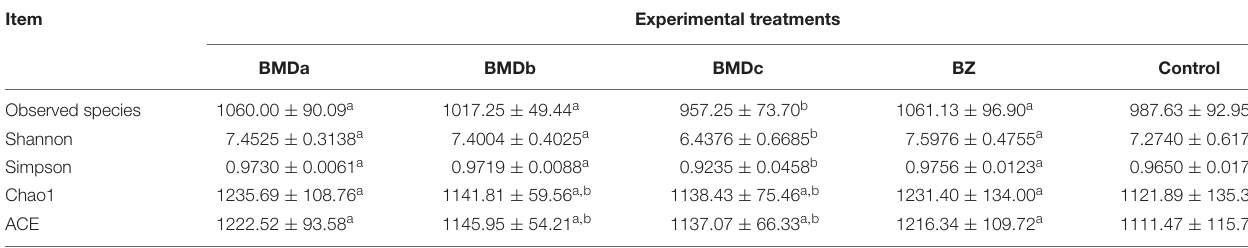
TABLE 3 | Number of observed species, richness, and diversity indices in the cecal content of each treatment.